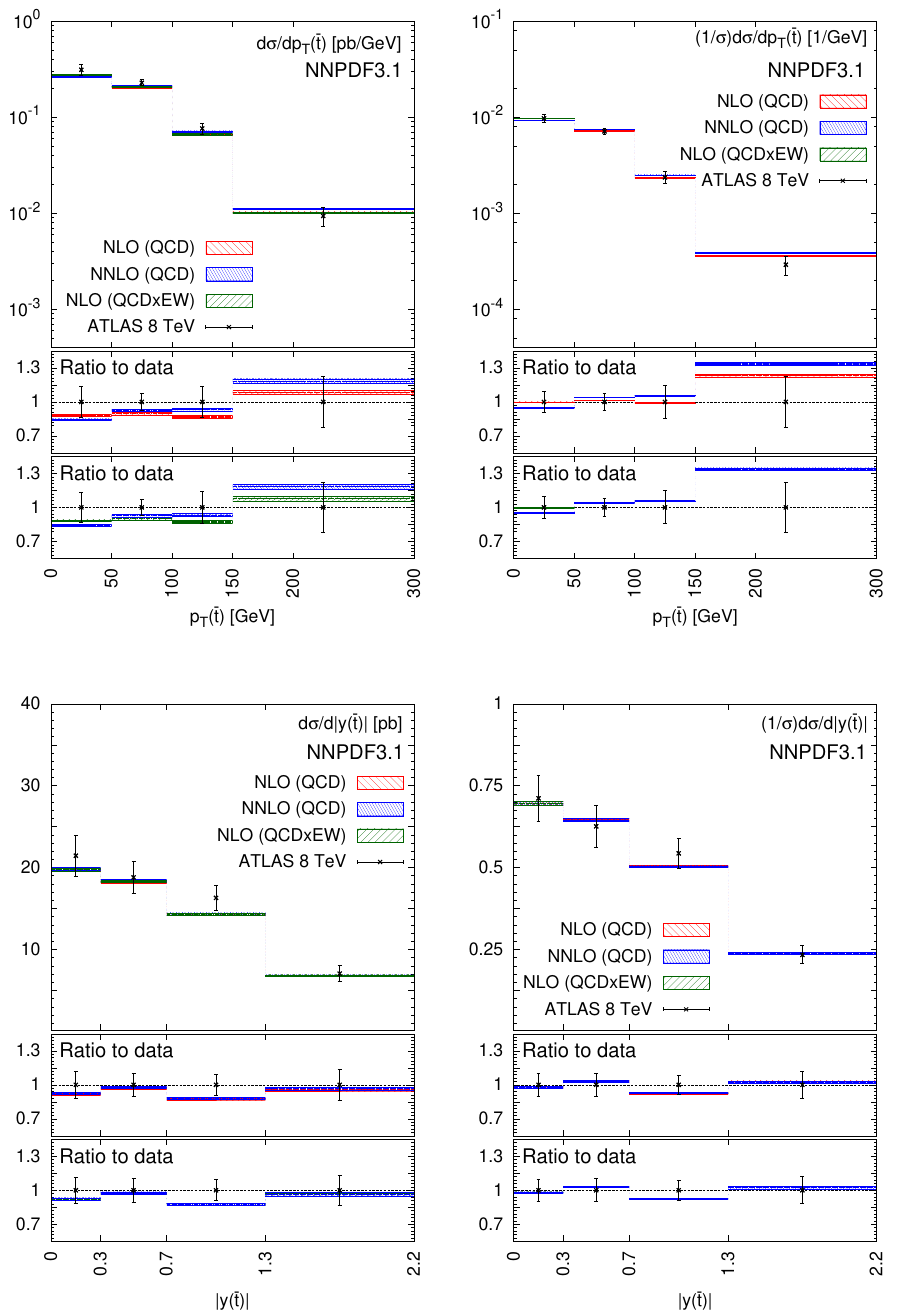
Figure 19 . Same as (cid:12)gure 4, but for the ATLAS data of ref.